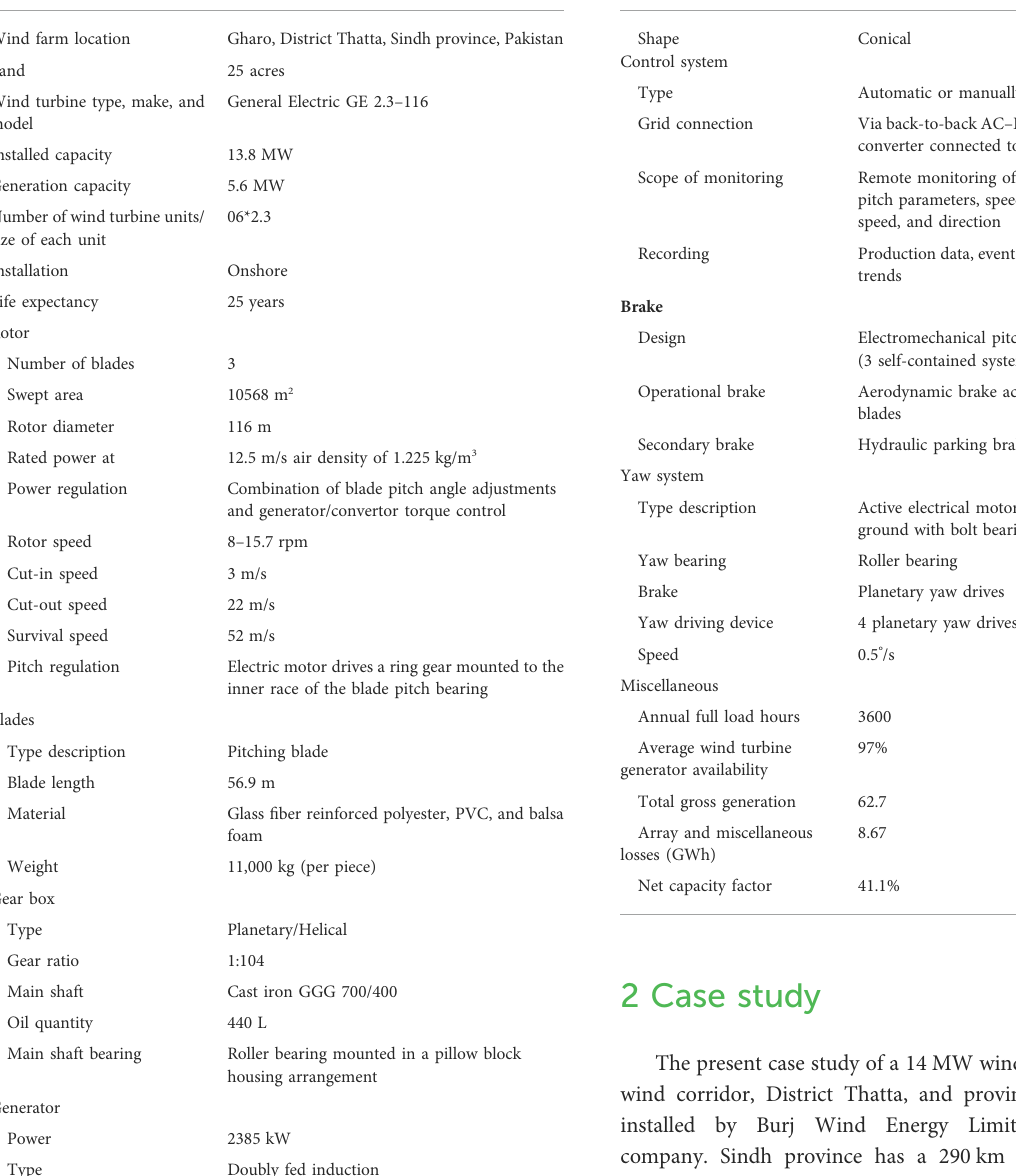
TABLE 2 Technical speci fi cations of the Gharo wind